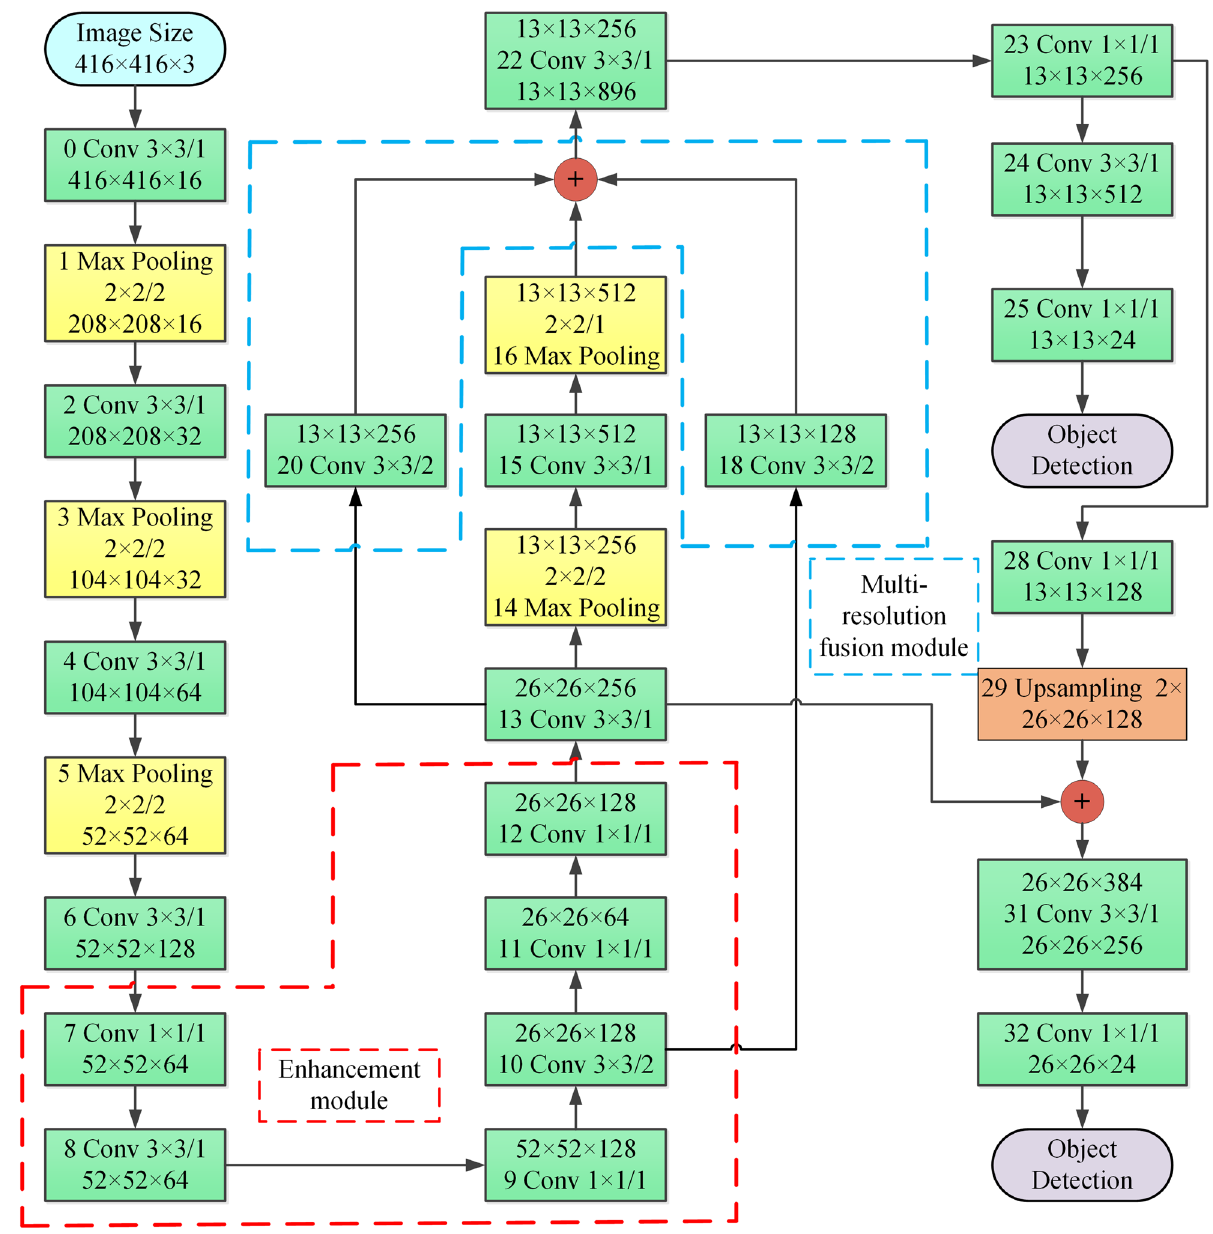
Figure 4. Optimized tiny YOLOv3 algorithm